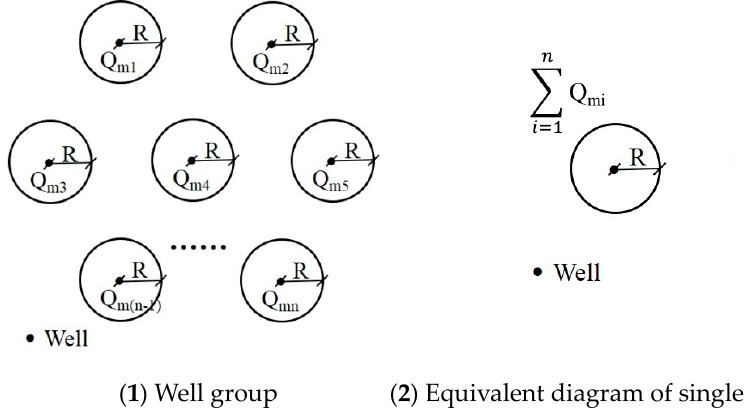
Figure 4. Influence radius in well group pumping and single well pumping in influence radius theory. R is the influence radius, [L]; Q mi is the maximum water yield of pumping well i, [L 3 T − 1 ]; and n is the number of pumping